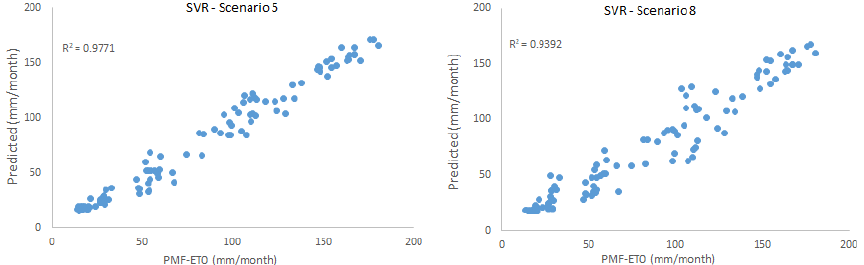
Figure 6. Scatter plots comparing SVR-estimated and FAO56PM-estimated ET 0 in scenarios 5 and 8.